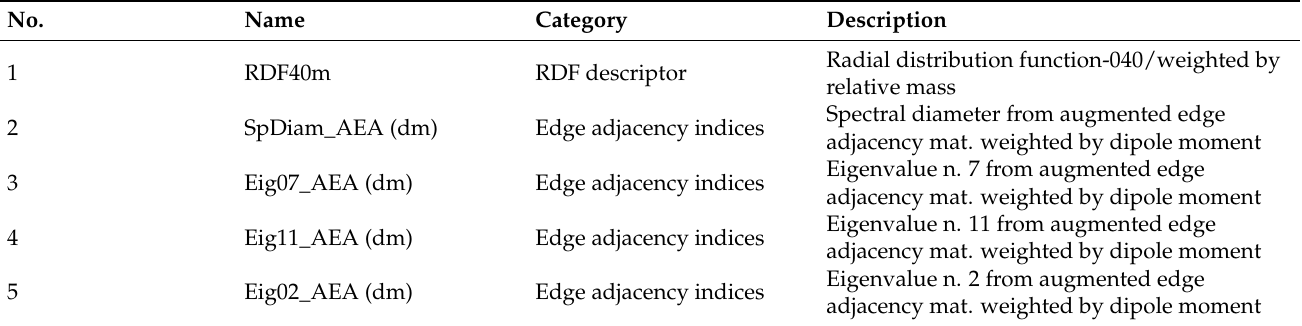
Figure 4. Pearson correlation of features with dependent variable (PCE). Table 1. Detail of selected molecular descriptors.